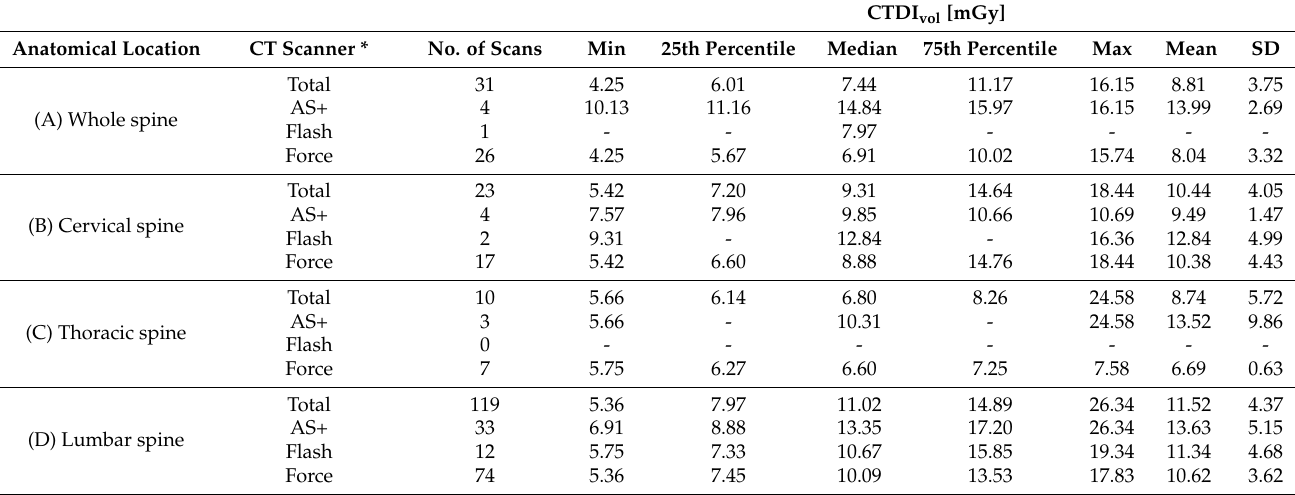
Table 2. Volume-weighted CT dose index (CTDI vol ) of CT myelography.